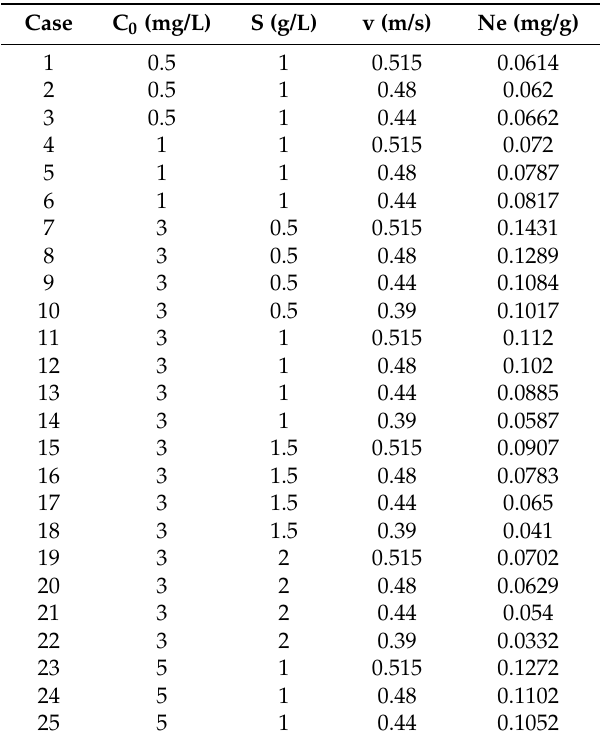
Table 1. C 0 , S, v and the balanced adsorbed phosphorus amount per unit mass sediment Ne of various cases in the physical